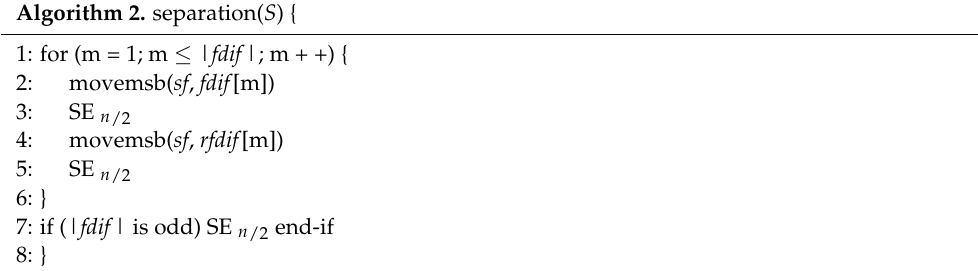
Algorithm 2. separation( S ) {